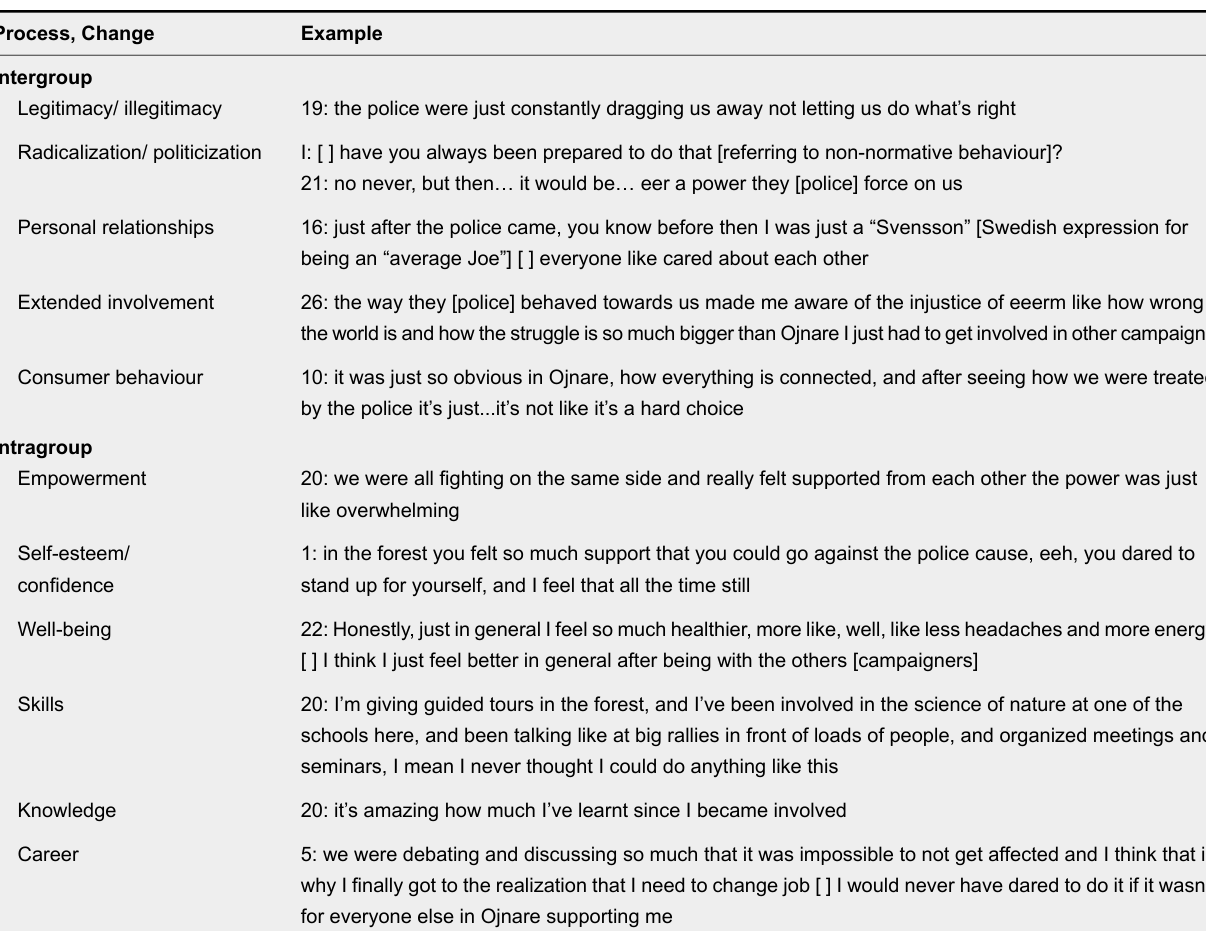
Process Linked to Type of